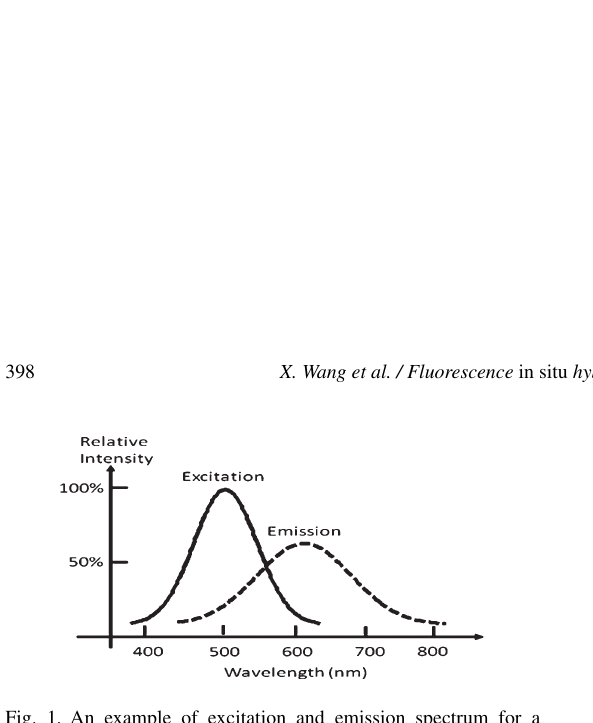
Fig. 1. An example of excitation and emission spectrum for a fluorochrome. additional fluorochrome in fluorescent green